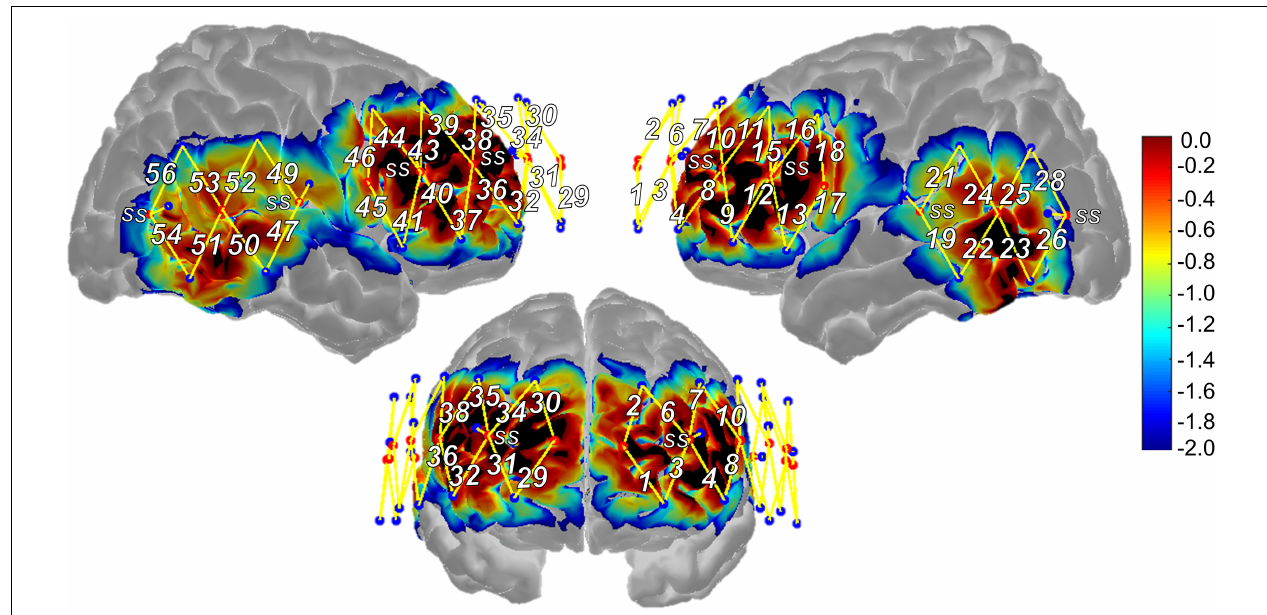
FIGURE 2 | Functional near-infrared spectroscopy probe design and sensitivity profile. SS, short-separation regression channel, Warmer colors suggest higher sensitivity to cortex, cooler colors suggest lower sensitivity to cortex.